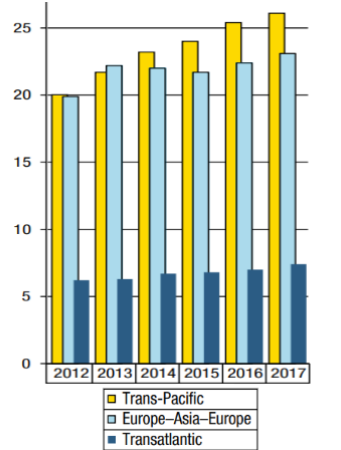
Figure 9 Estimated containerized cargo flows on major East- West trade routes 1995-2017 (Millions of TEU). Readapted from UNCTAD, 2017.